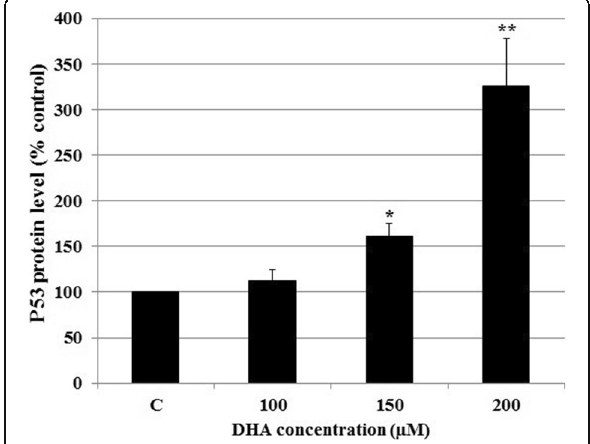
Fig. 5 Effect of DHA on the microRNA-16-1 expression. 5×10 5 HCT-116 cells per well were treated with 100 and 150 μ M/L DHA for 48 h, after which microRNA-16-1 expression levels were measured by real-time RT- PCR method. Parallel Real time RT-PCR with U6 snRNA specific primers was performed to normalize the equal loading. The results were pre- sented as mean±SD. * P <0.05 vs. untreated control cells